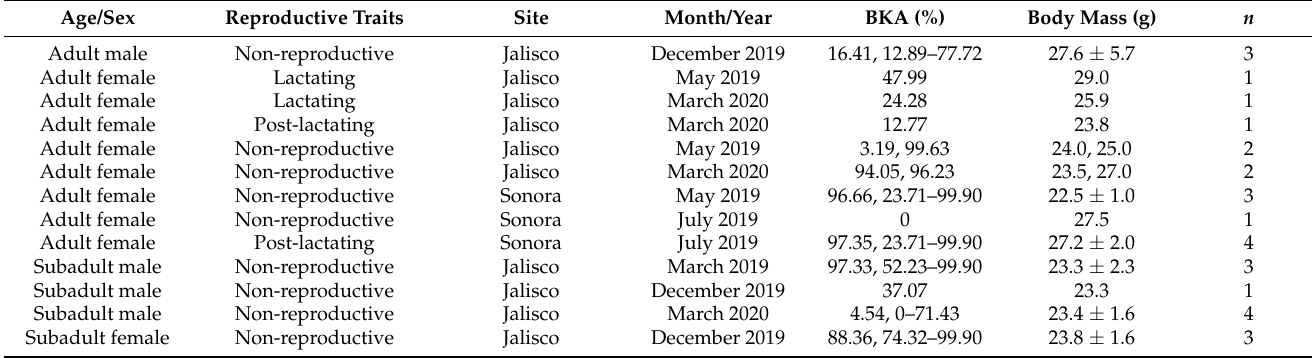
Table 1. Bacteria-killing abilities (BKAs; median, interquartile range) and body masses (mean ± SD) of lesser long-nosed bats ( Leptonycteris yerbabuenae ) not included in the statistical models due to small sample sizes. Individual values are shown when n < 3. Non-reproductive adult males in December 2019 presented scrotal testicles and dry dorsal